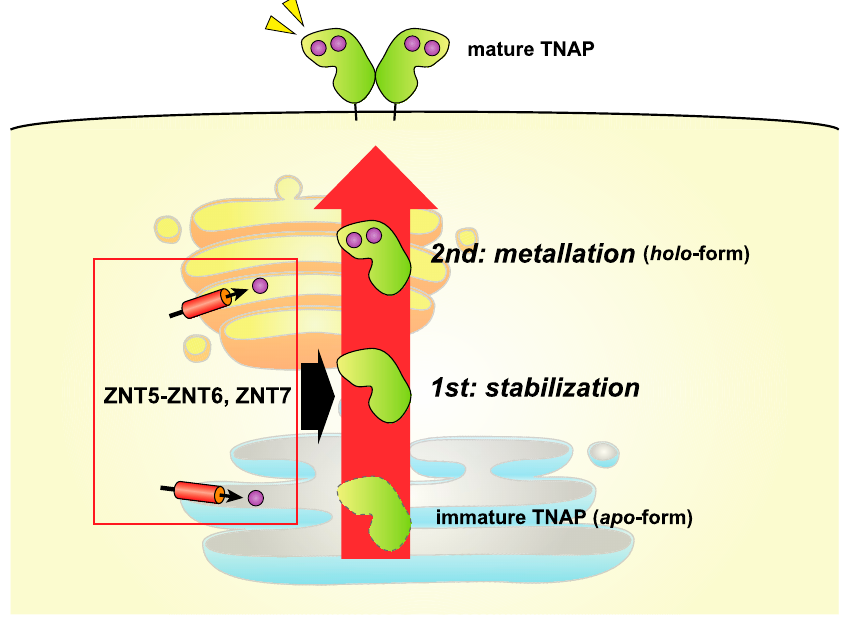
Figure 4. ZNT5-ZNT6 heterodimers and ZNT7 homodimers function to activate tissue-nonspecific ALP (TNAP) in a two-step mechanism. TNAP is specifically activated in a two-step mechanism involving ZNT5-ZNT6 heterodimers and ZNT7 homodimers as follows: first, the apo-form of TNAP is stabilized by either ZNT5-ZNT6 heterodimers or ZNT7 homodimers; second, the apo-form of TNAP is converted to the holo -form by zinc metallation. The PP-motifs in ZNT5 and ZNT7 likely play important roles in this process (see text). TNAP possesses a bimetallic core, is dimeric, and is localized to the plasma membrane via a glycophosphatidylinositol anchor. The subcellular localizations of ZNT5- ZNT6 heterodimers or ZNT7 homodimers have not been well defined. Zn: zinc. Znt5 or Znt7 knockout (KO) mice show various phenotypes [101–105], but the association of